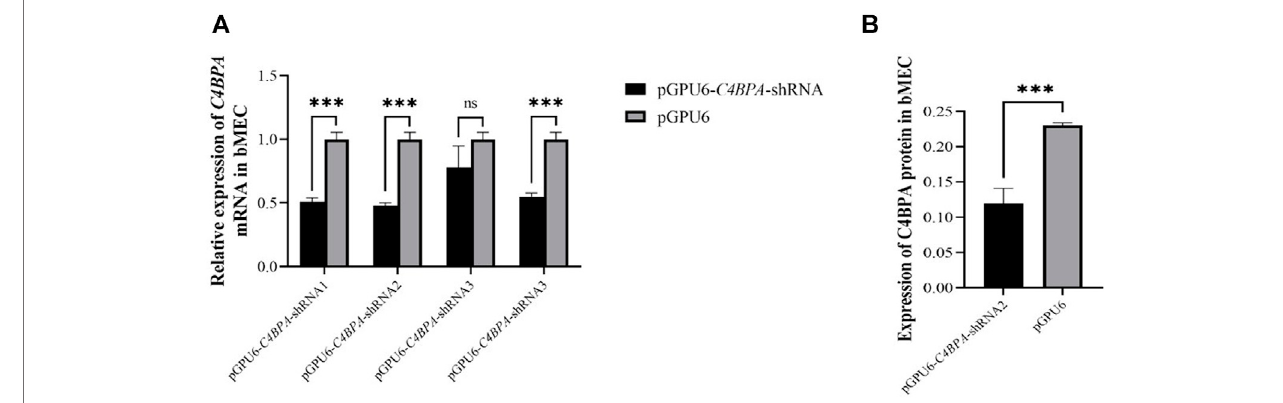
FIGURE2| Therelativeexpressionof C4BPA atmRNAandproteinlevelindifferentexperimentalgroupsofbMECs. (A) RelativemRNAexpressionof C4BPA gene after 24 h of transfection with pGPU6 C4BPA -shRNA1, pGPU6- C4BPA -shRNA2, pGPU6- C4BPA -shRNA3, pGPU6- C4BPA shRNA4, and pGPU6 in bMECs. (B) Relative protein expression of C4BPA after 24 h of transfection with pGPU6-C4BPA-shRNA2.